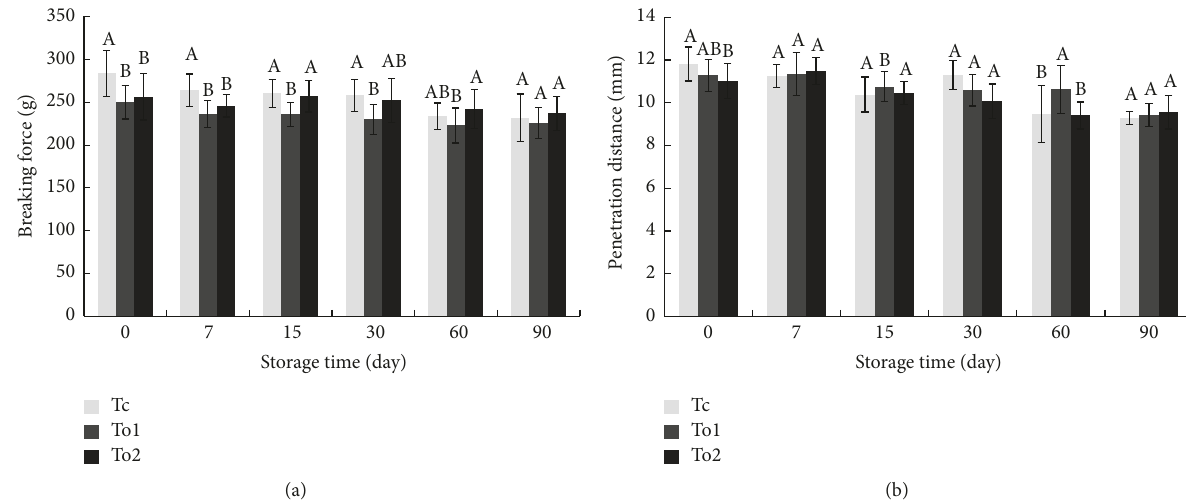
Figure 5: Changes in breaking force (a) and penetration distance (b) of silver carp surimi gels during frozen storage. Light grey: two washing cycles using ice water only (Tc); dark grey: first and second washing cycle using ice water containing 8 mg/L ozone and ice water, respectively (To1); black: first and second washing cycle using ice water and ice water containing 8mg/L ozone, respectively (To2). Different letters indicate significant difference among samples (Tc, To1, and To2).